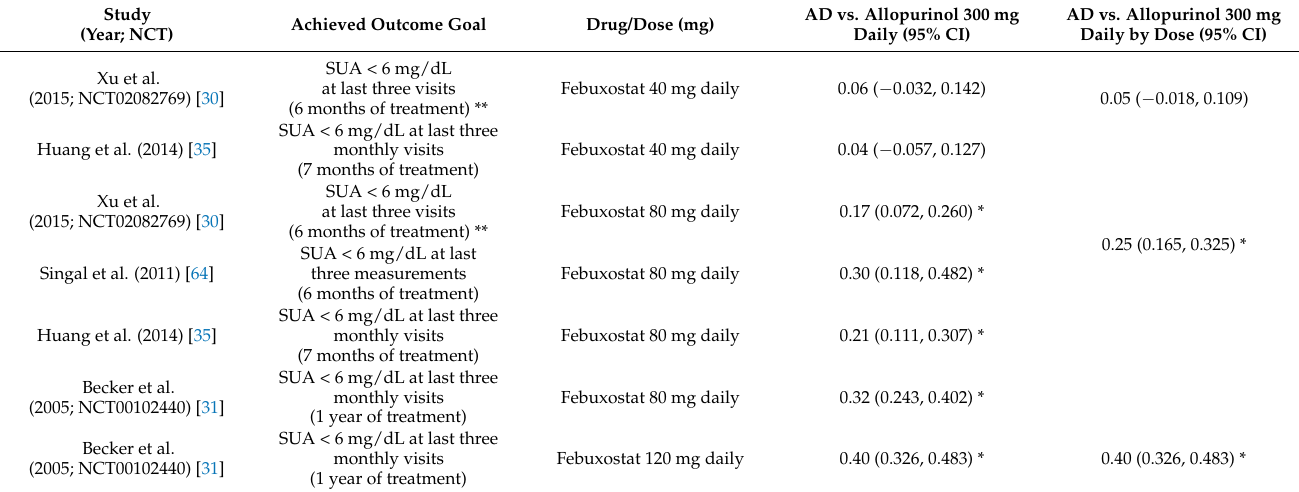
Table 5. Serum uric acid-lowering Achievement Difference vs. allopurinol 300 mg daily.